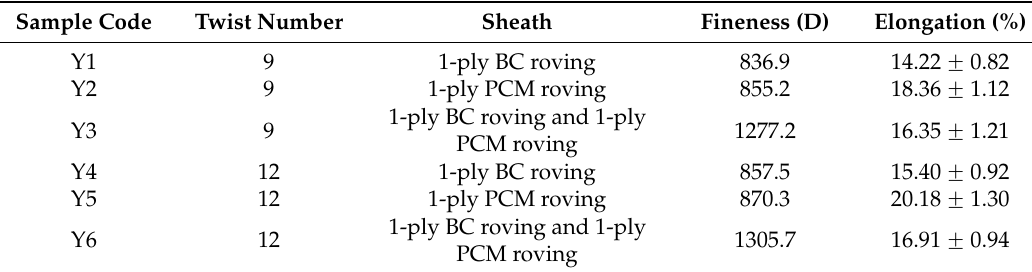
Figure 2. Configuration of ring spinning frame. Table 1. Physical properties of ring ‐ spun complex yarn.